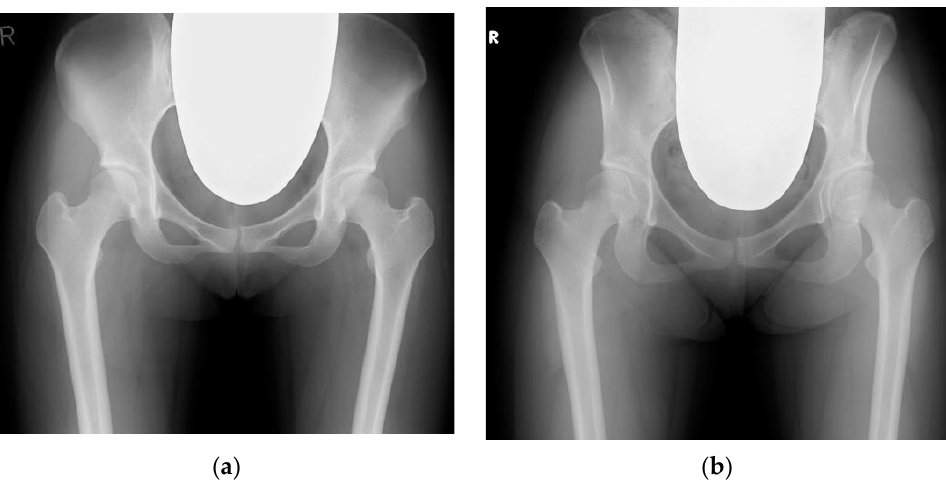
Figure 3. Development of dysplasia of the hip with varying severity. ( a ) Dysplasia of the acetabulum with pelvic incidence of 46°. ( b ) Dysplasia of the entire pelvis from the acetabulum to ilium (iliac wing curved inward) with pelvic incidence of 52°.